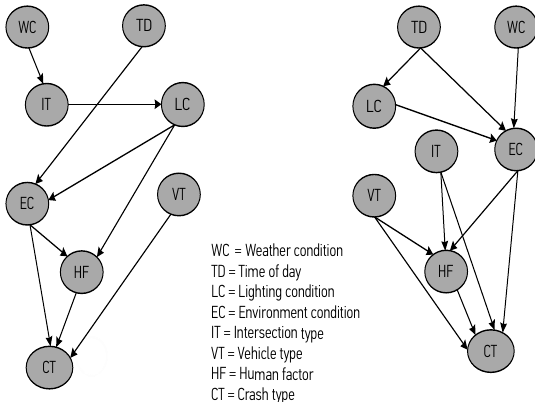
Fig. 3. Learned and optimized BN structures of urban intersection crash variables: a – learned structure; b – optimized structure